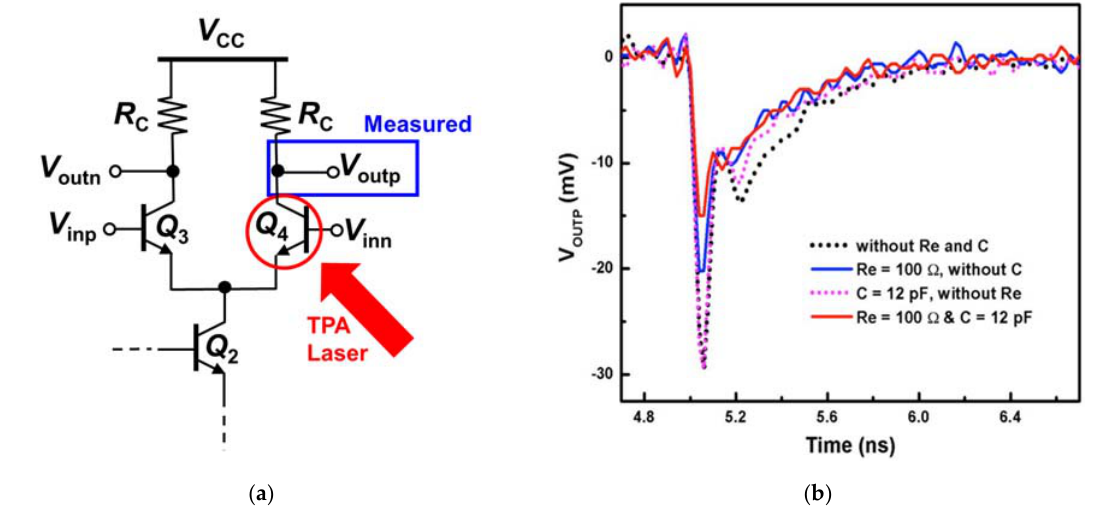
Figure 5. ( a ) Transistor Q 4 of the di ff erential input pair of all four CML circuits in Figure 2 was struck by the TPA laser; ( b ) Transient responses at the positive di ff erential output terminal (Q 4 collector) was